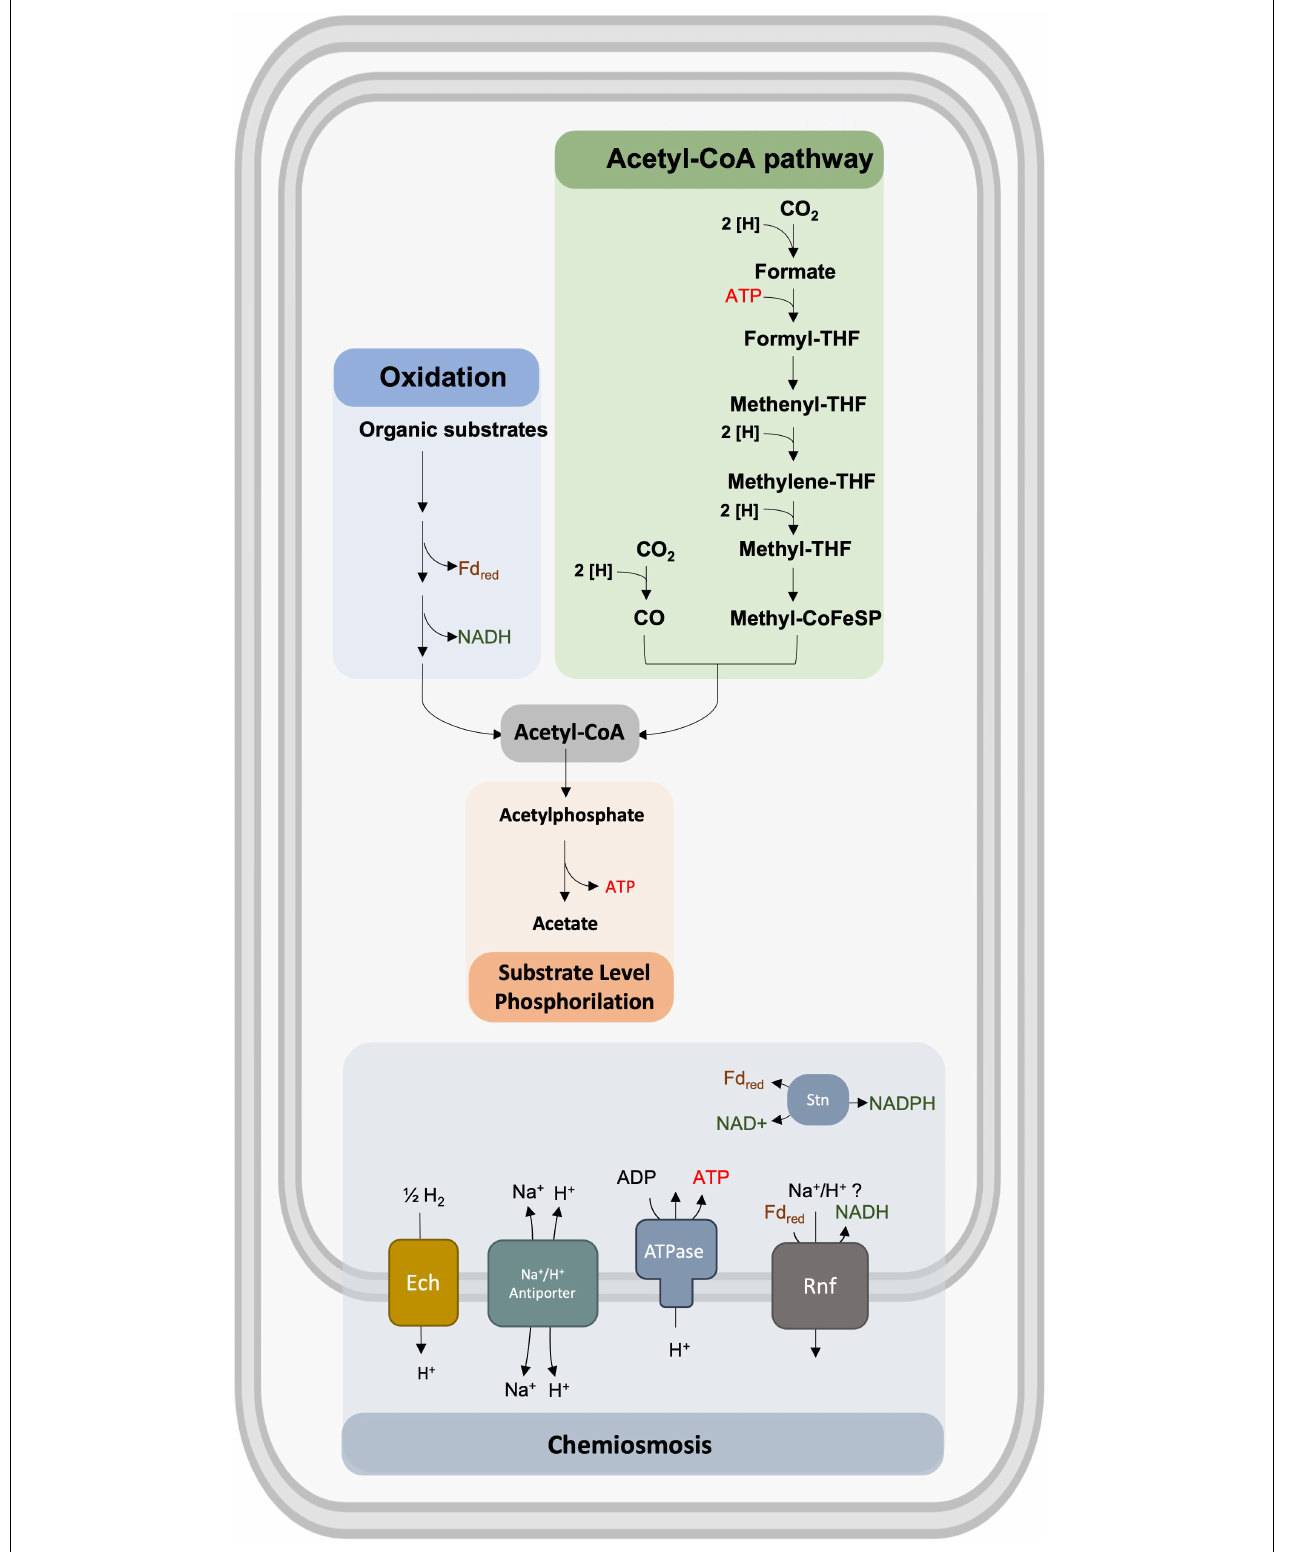
FIGURE 2 | Representation of the bioenergetic metabolism of S. ovata that includes the acetyl-CoA pathway, the oxidation of organic substrates, the generation of ATP by substrate-level phosphorylation (SLP), and chemiosmosis.